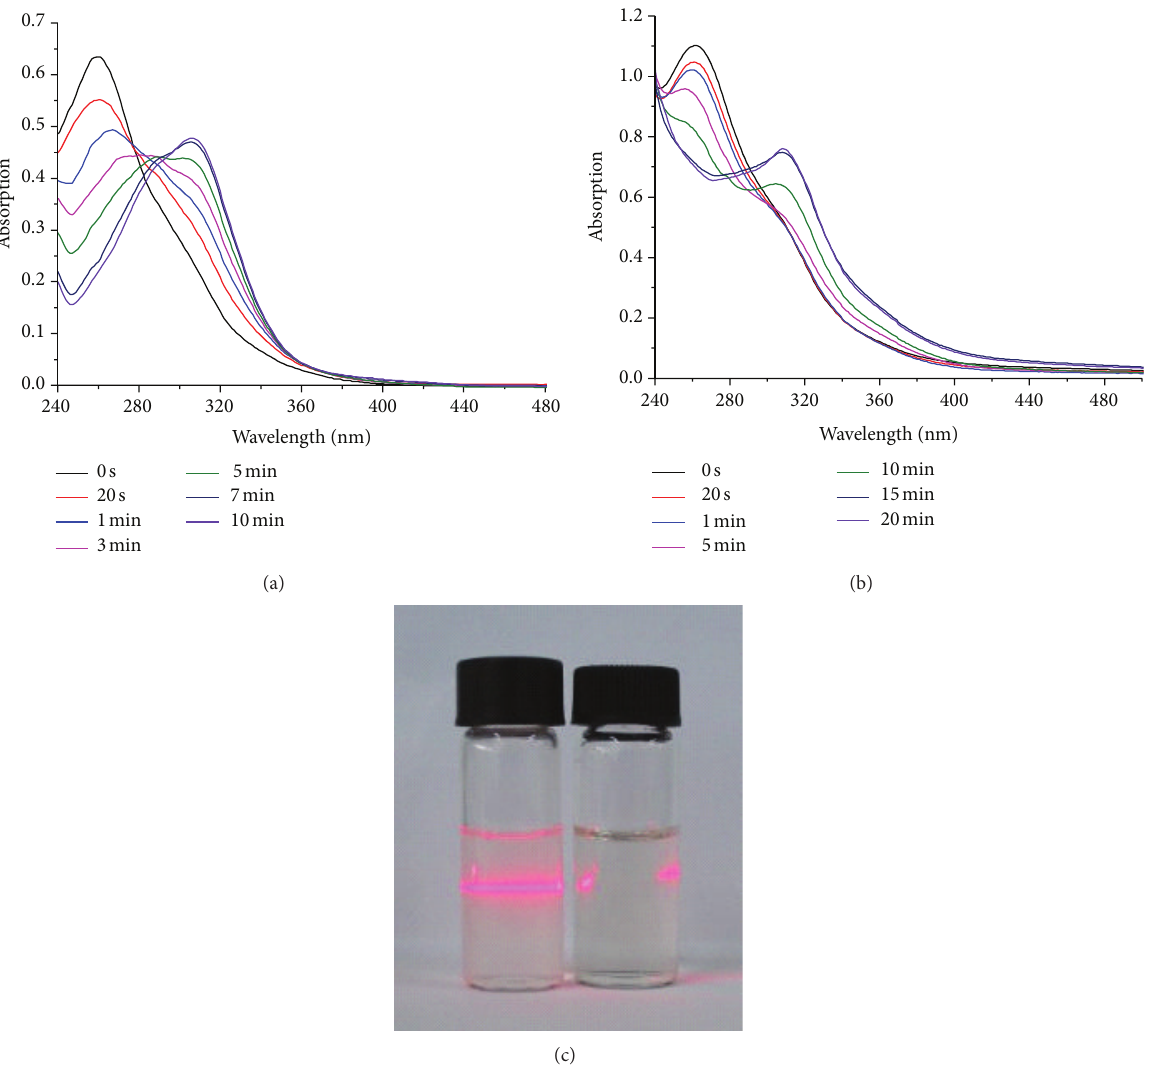
Figure 4: UV-vis spectra of (a) p1 micellar solution and (b) p2 micellar solution in water after various UV irradiation time; (c) photograph of the Tyndall effect of the p1 solution (0.8 mg/mL) before (left) and after (right) irradiation of UV light at 365 nm (2000 mW/cm 2 ) for